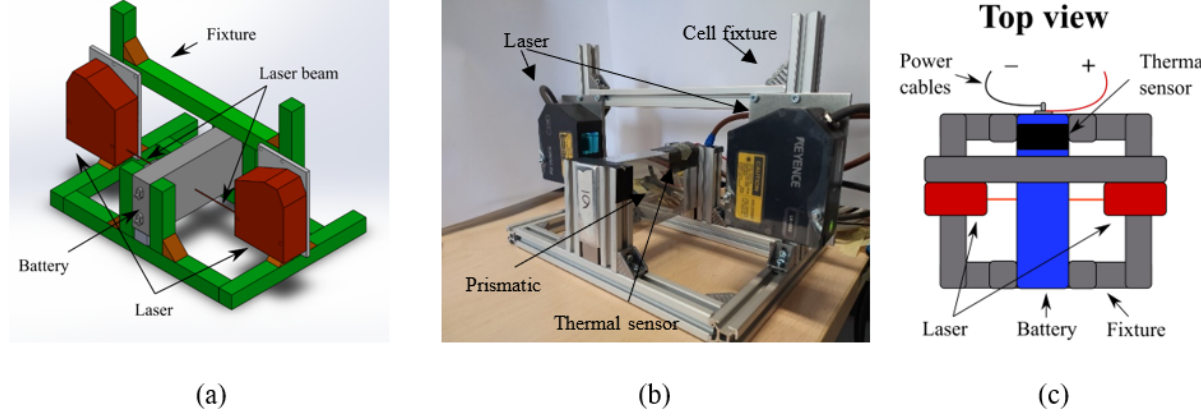
Figure 5. Optical measurement system: Conceptualization ( a ), realization ( b ) and the top view sketch ( c